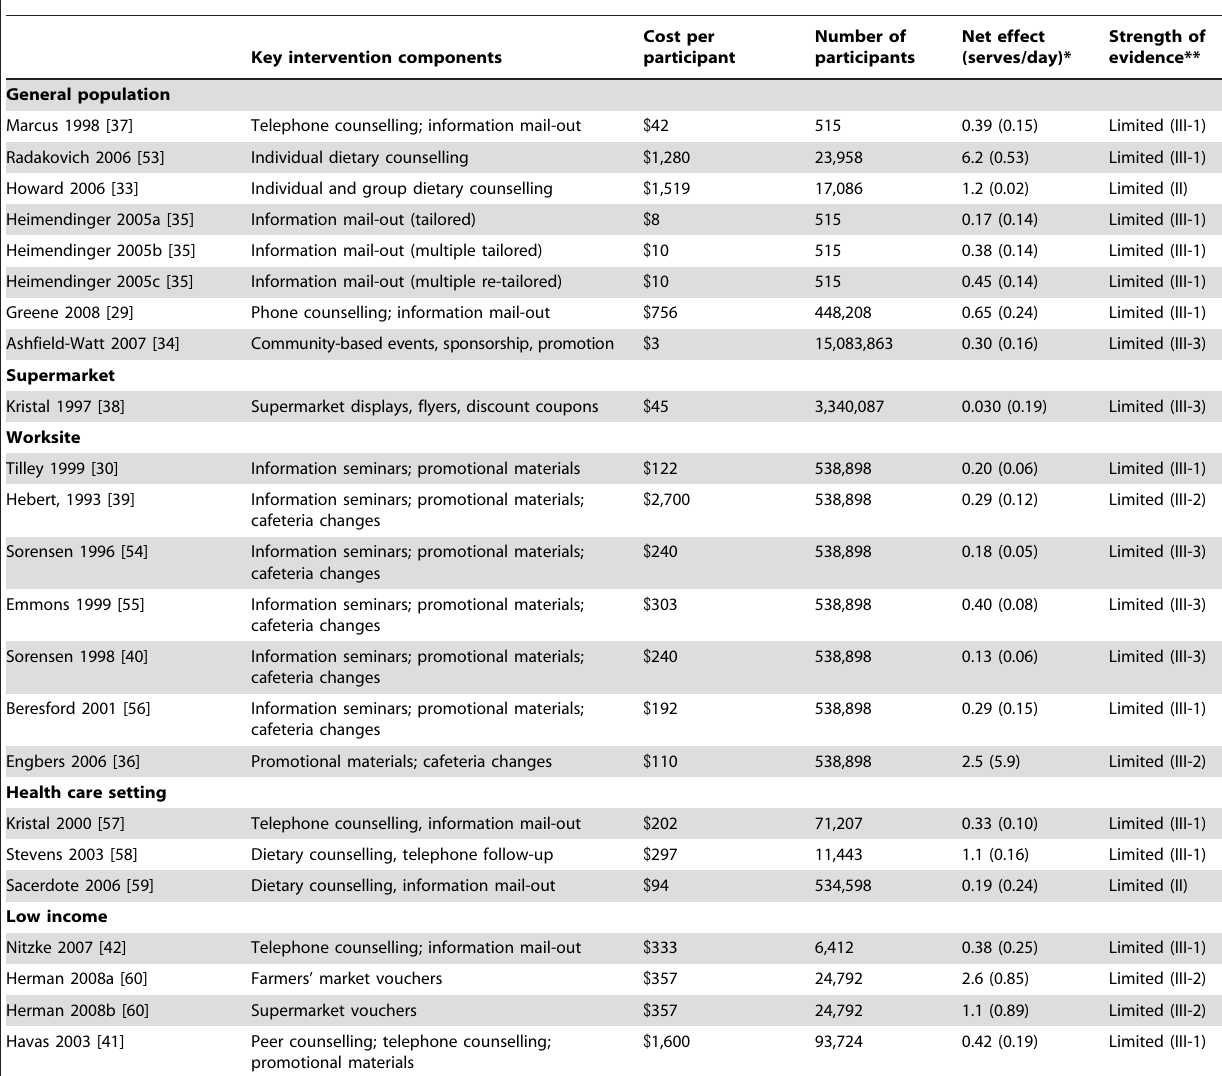
Table 3. Summary of key intervention components, cost per participant, the number of participants recruited (if rolled out in Australia), the net intervention effect on fruit and vegetable consumption and strength of evidence underlying the measure of